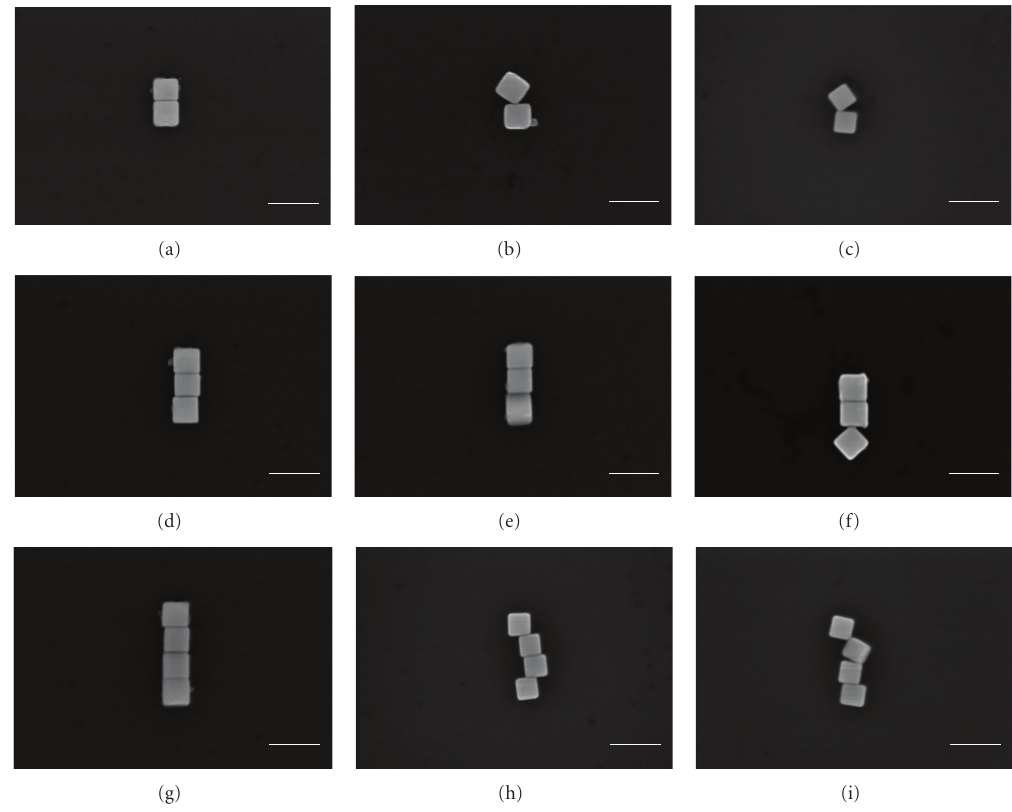
Figure 5: Collection of SEM images of silver nanocube dimers, trimers, and tetramers on silicon formed by the electrophoresis deposition method. The scale bar size is 200 nm. Images (a), (d) and (g) show examples of nanocube clusters with face-to-face